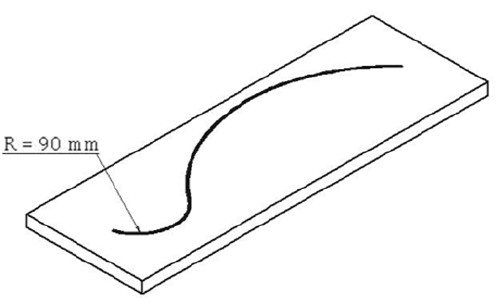
Figure 3: curve to model the bend of the left ventriculum where the lead is